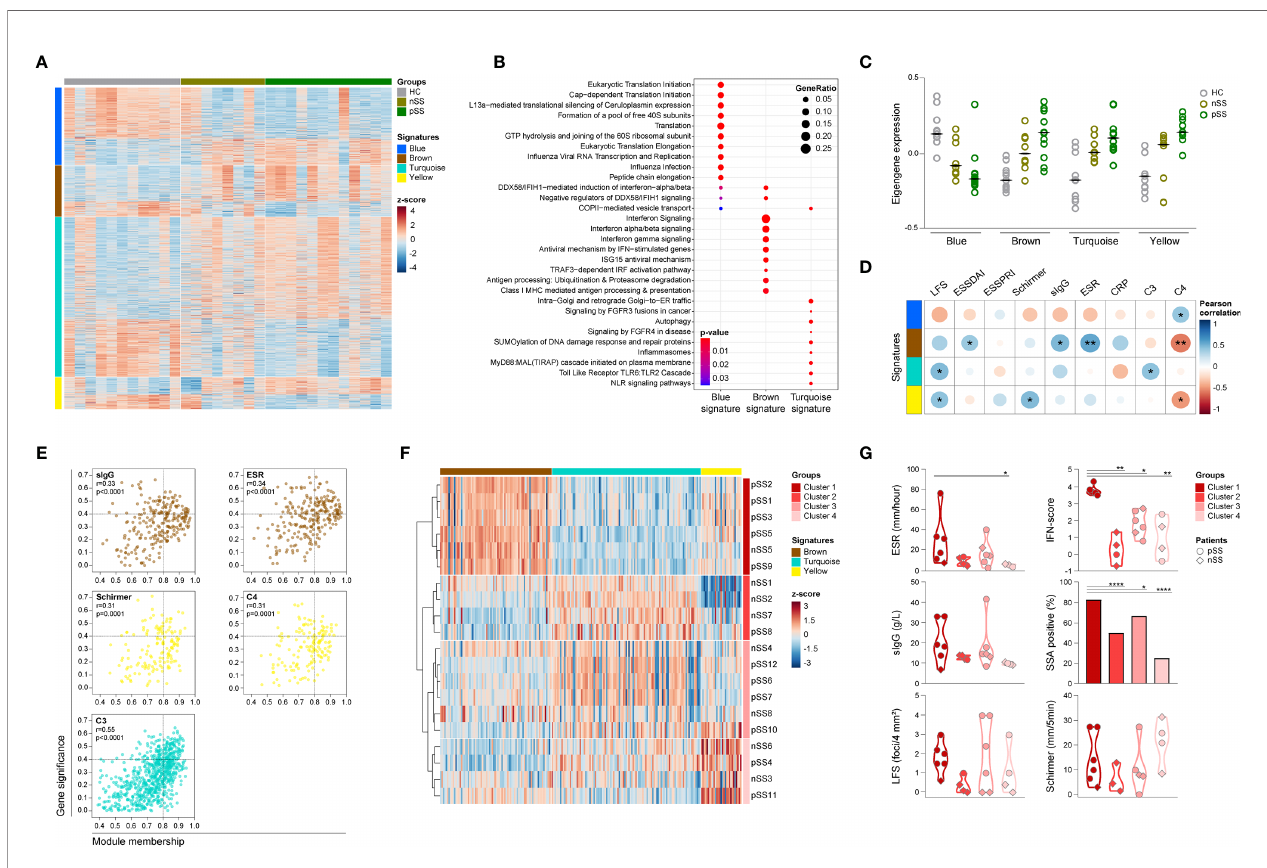
FIGURE 2 | Identi fi cation andfunctional characterization ofpSS-monocytes signatures revealsassociationswith markersoflocal and systemic in fl ammation.Weighted gene co-expression network analysis was performed to identify signatures ofco-expressed genes and their respective functional annotation.Heatmap visualization of the 1500 DEGs across the 4 identi fi edsignatures (blue, brown, turquoise and yellow;rows) and the studied groups(HC, nSS andpSS; columns) (A) . Reactome pathway enrichmentanalysiswas usedfor functional annotation of the signatures, there was no result for the yellow signature. Dot-size depicts the fraction ofthe genes within the pathway that is enriched,color indicates the statistical signi fi cance of the enrichment (B) . Eigengene expression ( fi rst principal component ofthe moduleexpression level) for each signature isdepicted for HC, nSS andpSS patients (C) . Correlation matrixof the moduleeigengenes and the clinical traits isdepicted. Signatures are shown inrows andthe clinical traits incolumns. Dot-size and color indicates the Pearsoncorrelation coef fi cient, p-values are shown inside the dots; (D) . Intramodular analysis identi fi es hub- genes related with markersofsystemicand local in fl ammation.Scatter plots of gene signi fi cance for the selectedclinical traitversusthe module membership per signature are depicted. Each dot represents one speci fi c gene within a signature. Hub-genes are de fi ned bya modulemembership of>0.8 and a gene signi fi cance of >0.4. Signatures can beidenti fi ed bythe corresponding color ofthe graph (E) . nSS and pSS patient were clustered using hierarchical clusteringof the selectedhub-genes using Euclidean distance andWard ’ s method.Hub-genes ofeach signature are shown incolumns andthe patient clustersare indicated in rows (F) . Violin plots depicts the expression of selected clinical parametersacross theestablished patientclusters (G) . *,**and **** representp < 0.05, p < 0.01, and p < 0.0001,